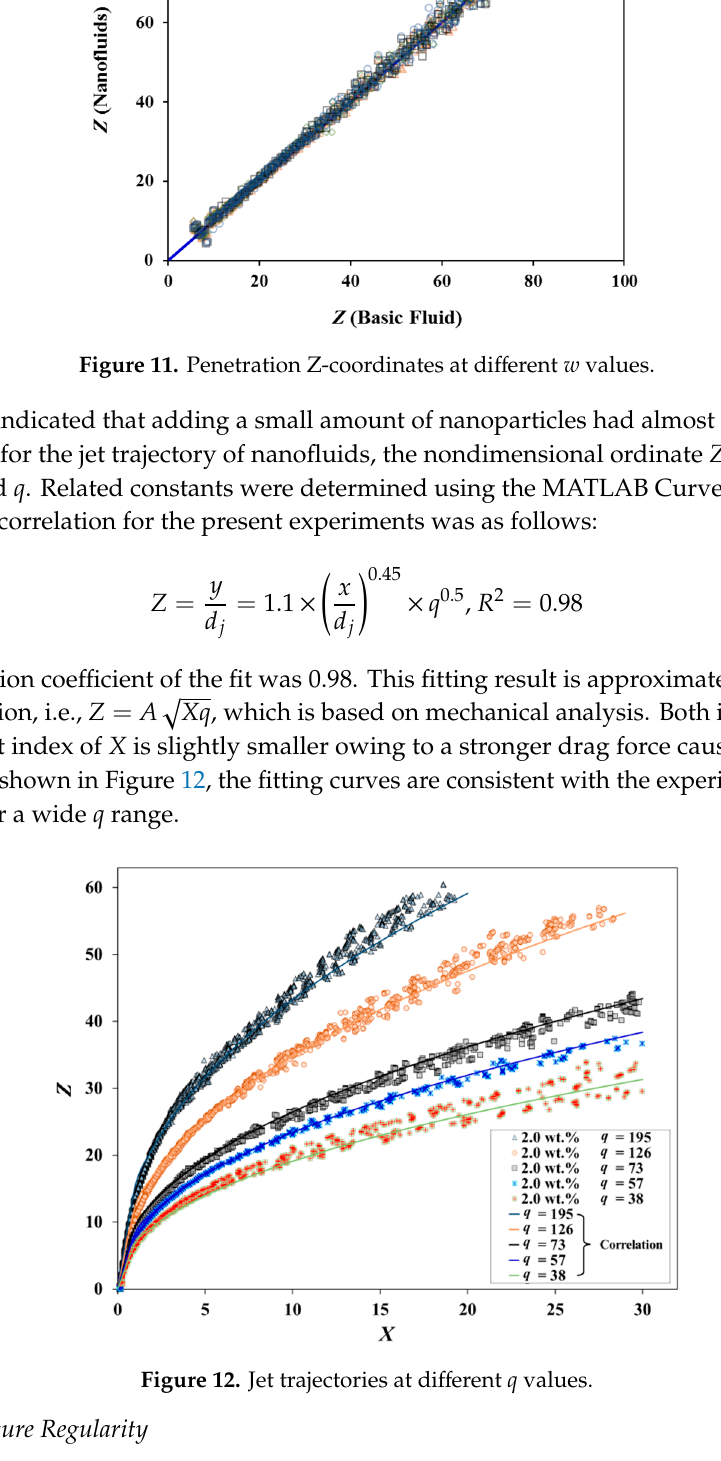
Figure 11. Penetration Z-coordinates at different w values.